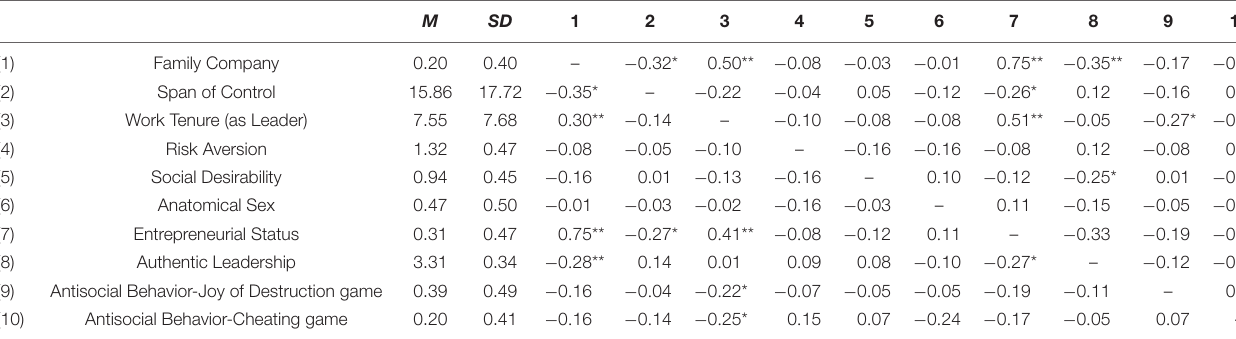
TABLE 2 | Phase 2 – Means, standard deviations, Kendall’s tau and Pearson’s bivariate correlations for all study